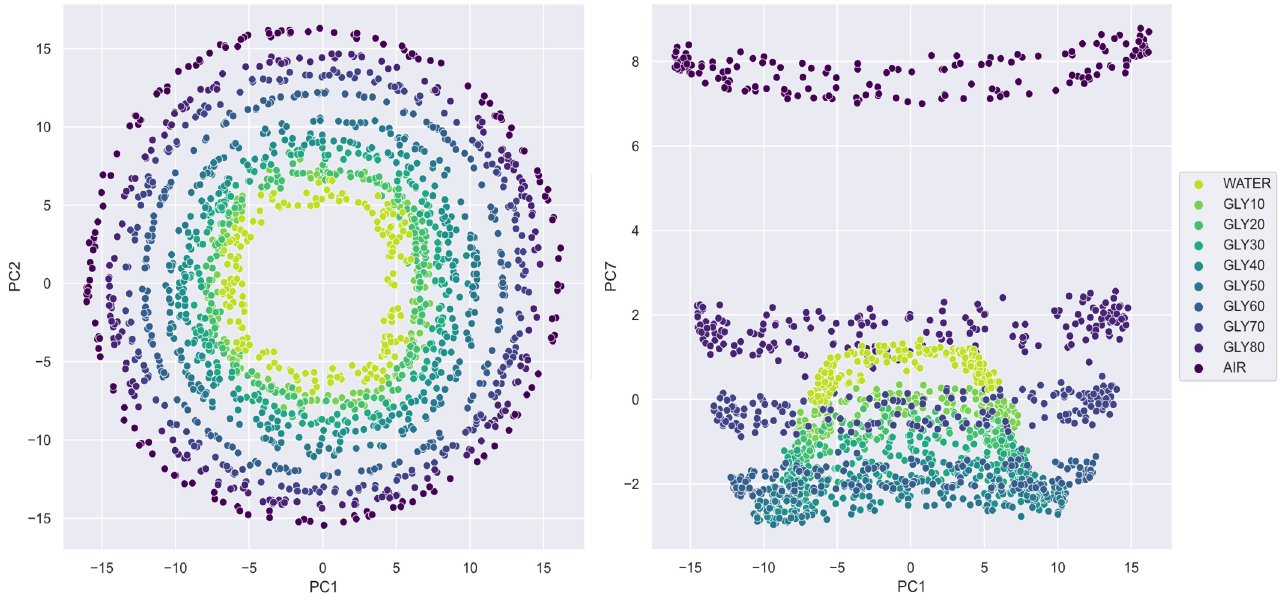
Figure 10. PCA sca tt er plots of ER signals. Figure 10. PCA scatter plots of ER